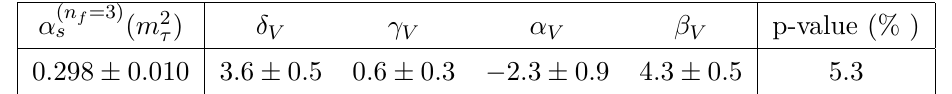
) , in FOPT, and the spectral ansatz parameters in eq. (4.2) τ